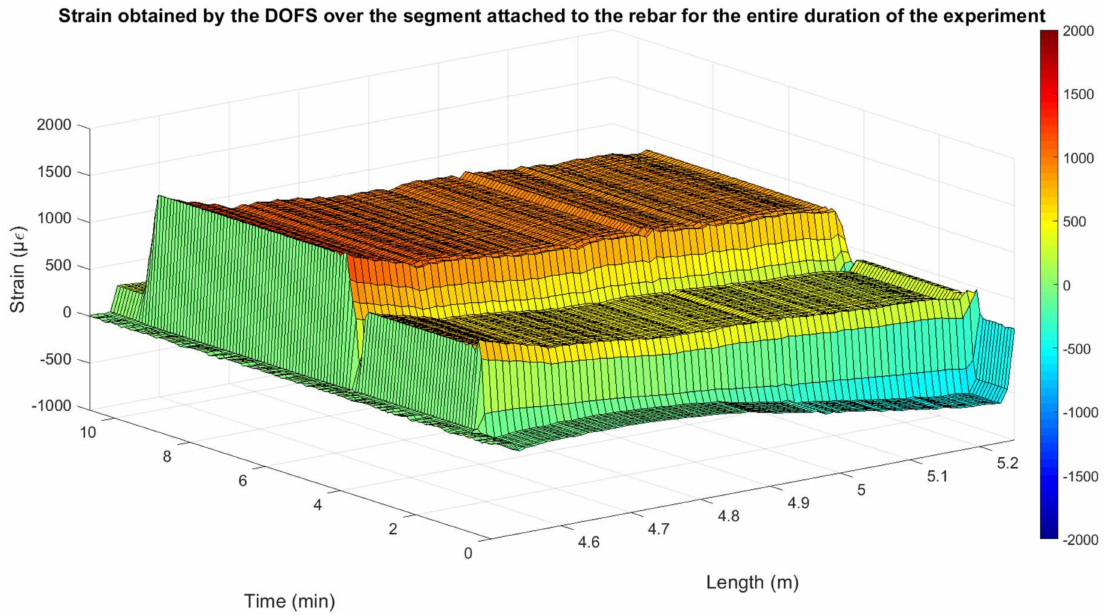
Figure 5. DOFS measured strain for rebar tensile